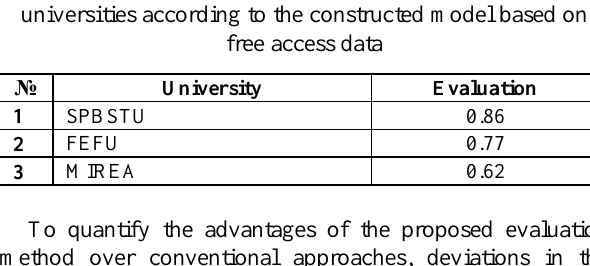
Table 8 – Education quality evaluation of Russian